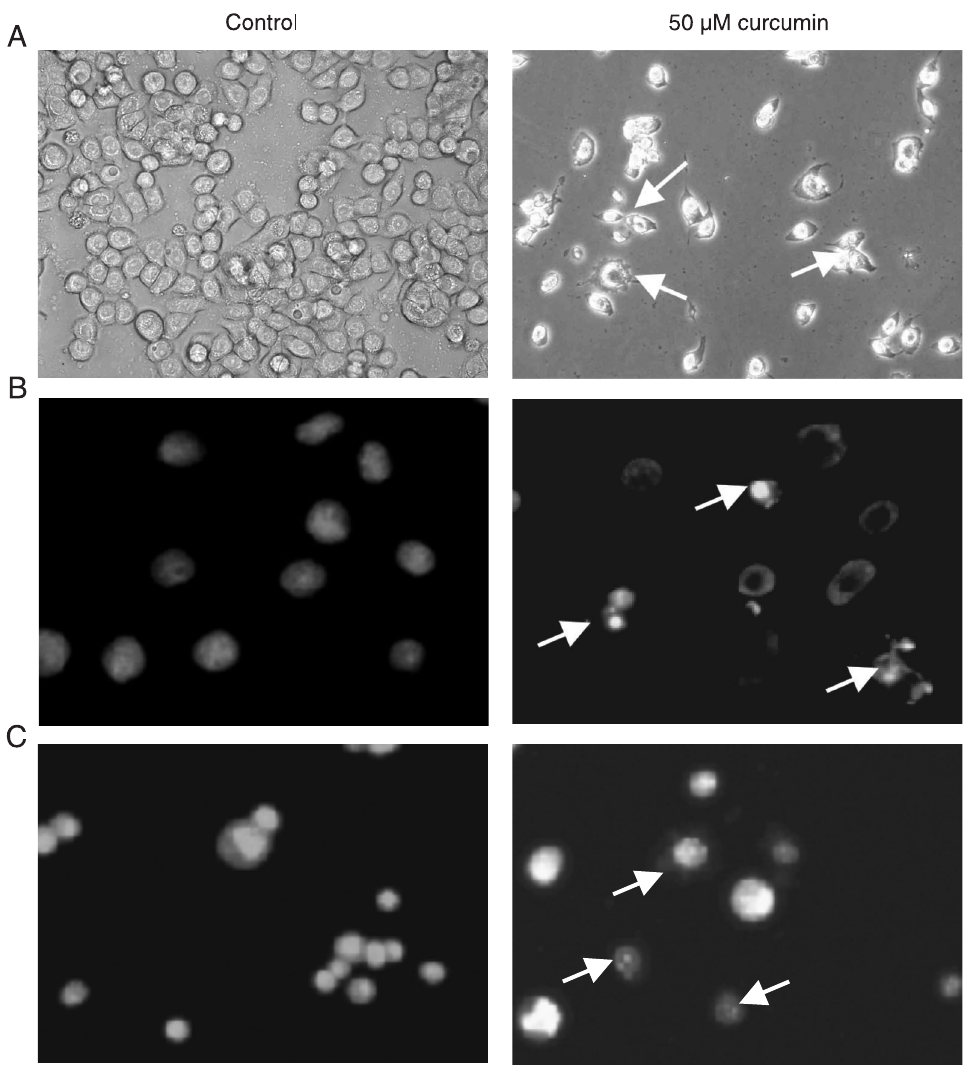
Figure 3. Morphological changes of HT-29 cells after exposure to curcumin. HT-29 cells were treated with DMSO (control) or 50 µM curcumin for 24 h. A , The images were captured by phase contrast microscopy (Leica DM IRB). Original magnification, 200X. B , Cells were fixed and stained with Hoechst 33258, and the images were captured by fluorescence microscopy (Leica DM IRB). Original magni- fication, 400X. C , Cells were harvested and stained with AO/ EB, and the images were cap- tured by fluorescence micros- copy (Leica DM IRB). Original magnification, 400X. The arrows indicate cells undergoing apop-